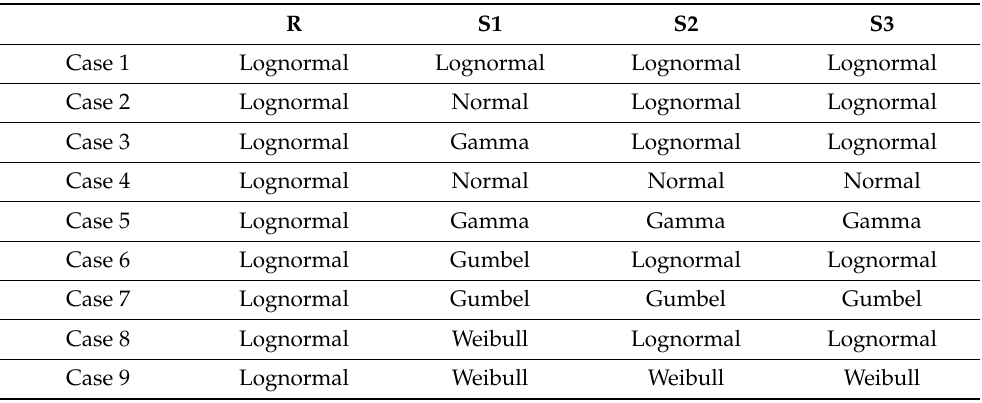
Table 7. Basic random